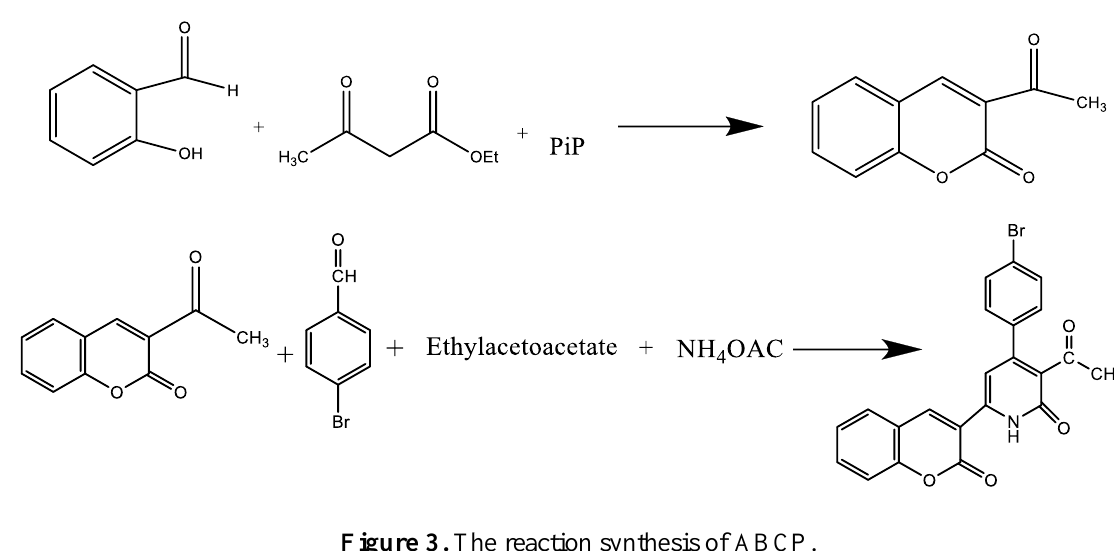
Figure 3. The reaction synthesis of